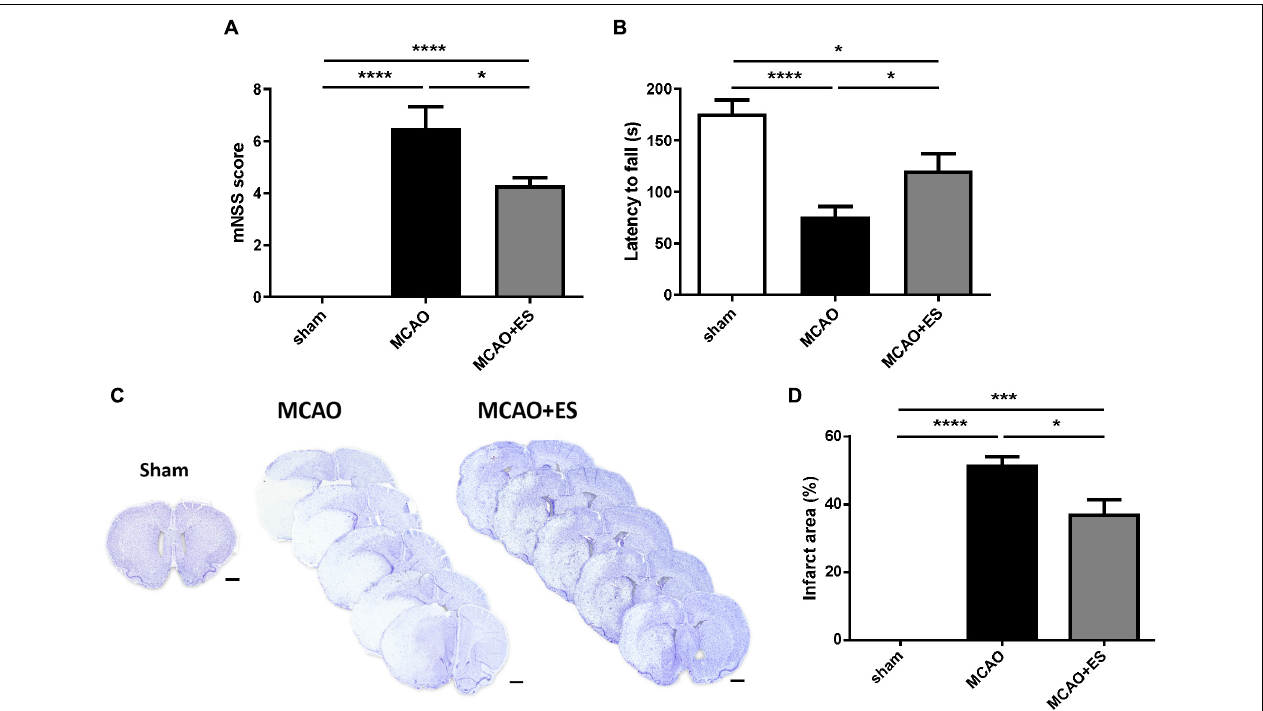
FIGURE 2 | Middle cerebral artery occlusion rats perform better functional outcome recovery and showed reduced infarct area after ES treatment. (A) ES attenuates functional deficits as evaluated by mNSS after tMCAO (Sham n = 10; MCAO n = 10; and MCAO + ES n = 10). (B) ES improves rotarod performance after tMCAO (Sham n = 10; MCAO n = 10; and MCAO + ES n = 10). (C) Representative pictures of crystal violet staining. Scale bar = 1 mm. (D) ES significantly reduces infarction volume after tMCAO (Sham n = 5; MCAO n = 10; and MCAO + ES n = 10). * p < 0.05; *** p < 0.001; and **** p < 0.0001.